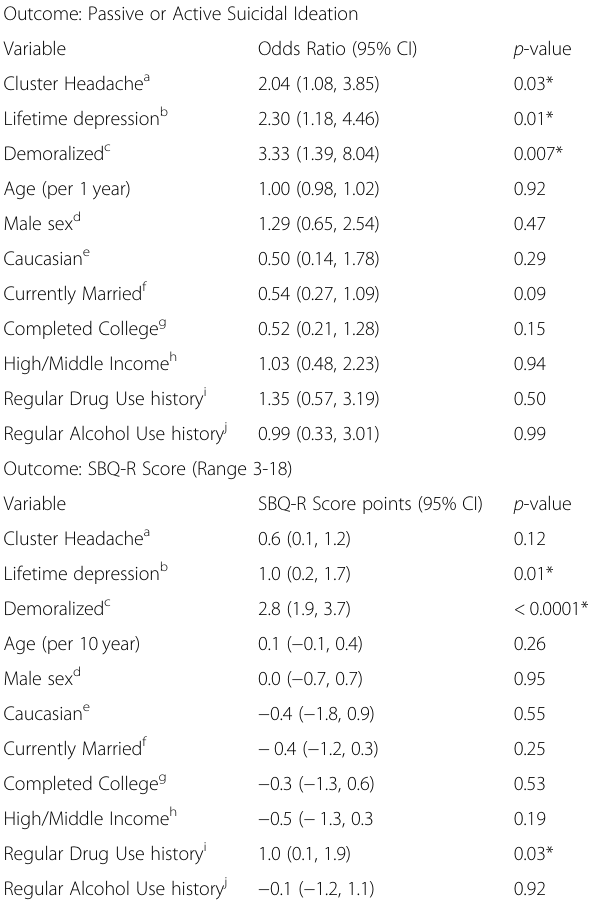
Table 3 Associations of Suicidal Ideation or High Suicide Risk in the Overall